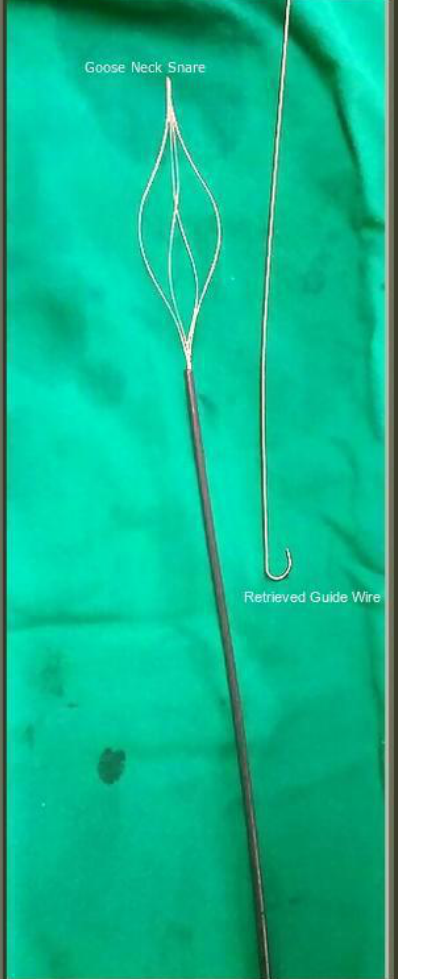
Figure 2: Retrieved “J”guide wire (right).Goose neck snare(left) used to retrieve “J” guide